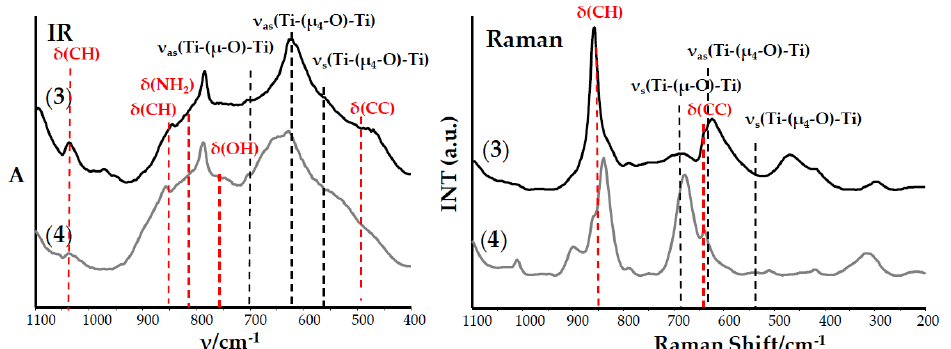
Figure 2. IR and Raman spectra of the ( 3 ) and ( 4 ) complexes. Table 2. Results of the vibrational spectra studies of the ( 1 ) – ( 3 ) complexes (the band intensity: strong (s), middle (m), weak (w), very weak (vw).